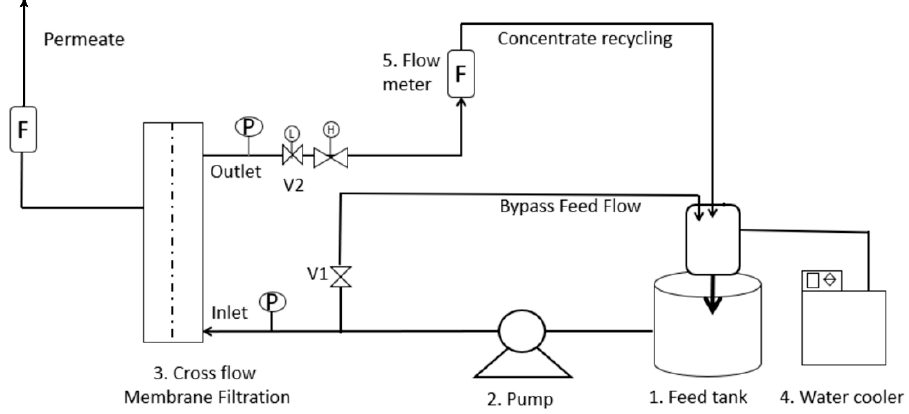
Figure 1. Schematic diagram of NF process.